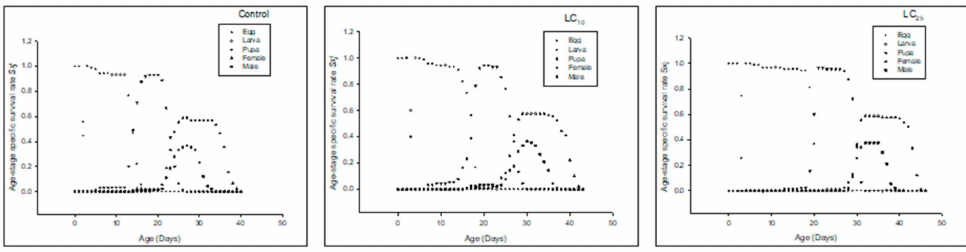
Figure 6. Age stage reproductive value ( v xj ) of the F 1 generation in Spodoptera frugiperda . The s xj of F 2 (second filial generation) denoted that the overall life span was prolonged in LC 10 and LC 25 compared to the control (Figure 7).